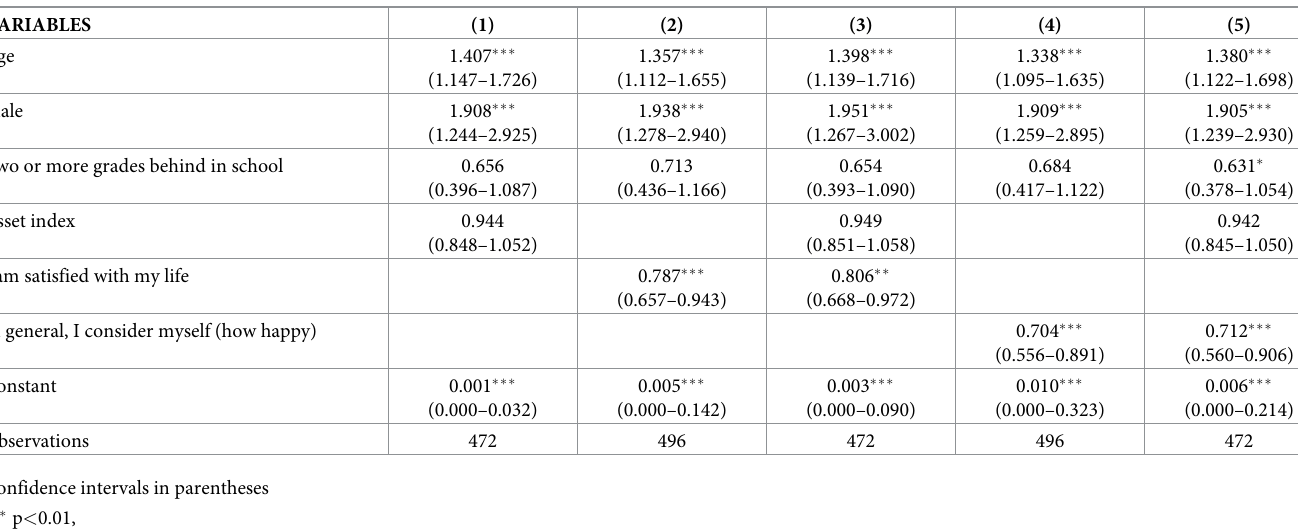
Table 8. Alcohol use: Logit regression, including happiness and life satisfaction, with or without assets, odds ratios reported.